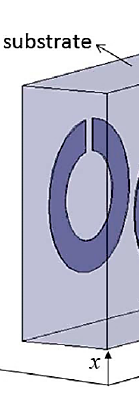
Figure 18. Schematic showing a waveguide probe positioned above a metal board. d is the standoff distance between the waveguide load and the surface of the metal plate (from [40]; copyright © IEEE 2014; reproduced with permission).